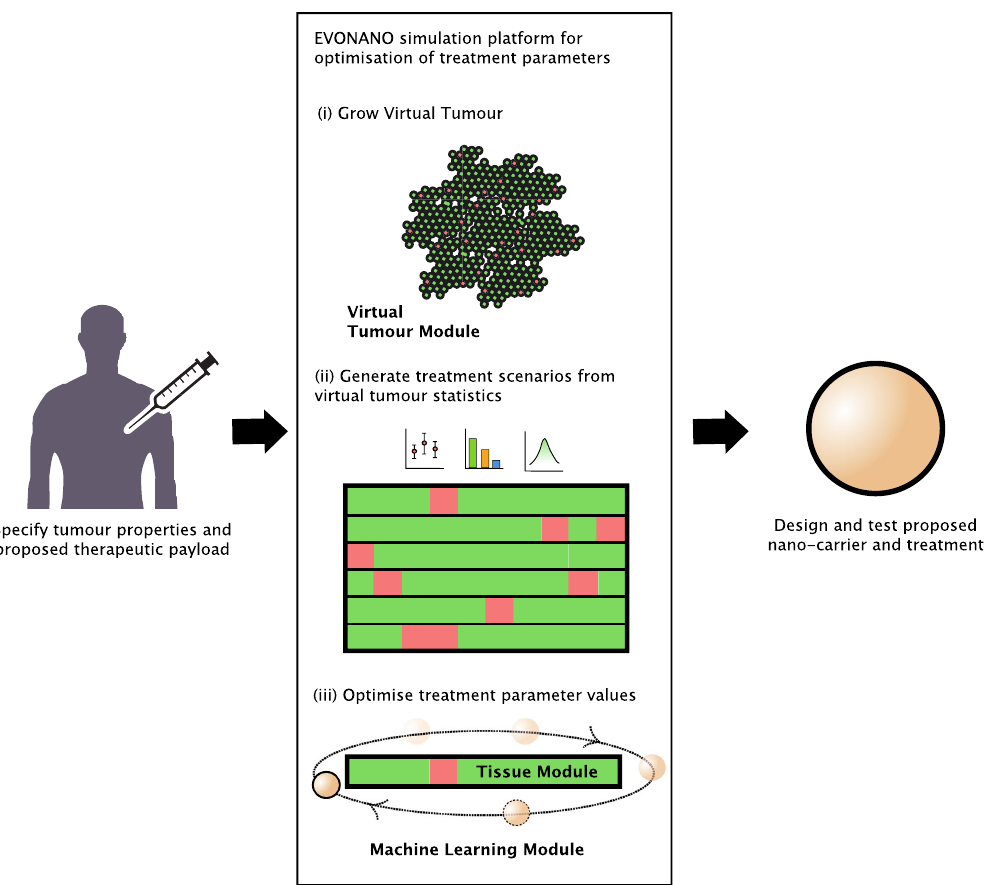
Fig. 1 General overview of the EVONANO platform. The EVONANO platform begins by (A) specifying tumour and possible nanocarrier properties which are then used as assumptions within the EVONANO simulation platform. This proceeds as follows: (i) we fi rst grow a virtual tumour to a suf fi cient size using the virtual tumour model, (ii) summary statistics, such as necessary penetration distance, are calculated from the virtual tumour and used to generate representative treatment scenarios, (iii) we then optimise the parameter values using the tissue module and machine learning module. The nanocarrier and treatment parameters can then be designed and tested using in vitro/in vivo